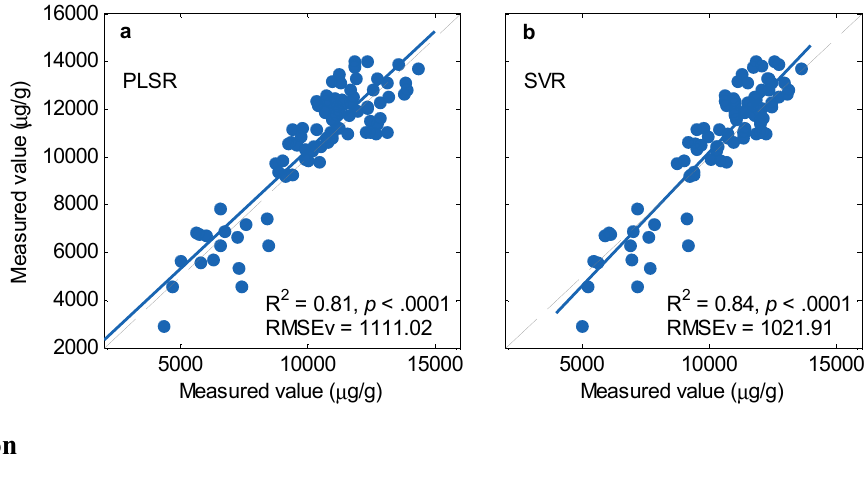
Figure 8. Measured-by-predicted values of LCC showing the validation results of ( a ) PLSR model and ( b ) SVR model in predicting the LCC of the validation data set. Solid and dashed lines show the best linear fit and 1:1 lines,